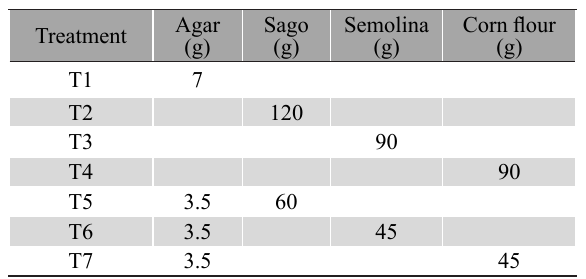
Table 3. Different gelling agents and their weight for treatments in KNC